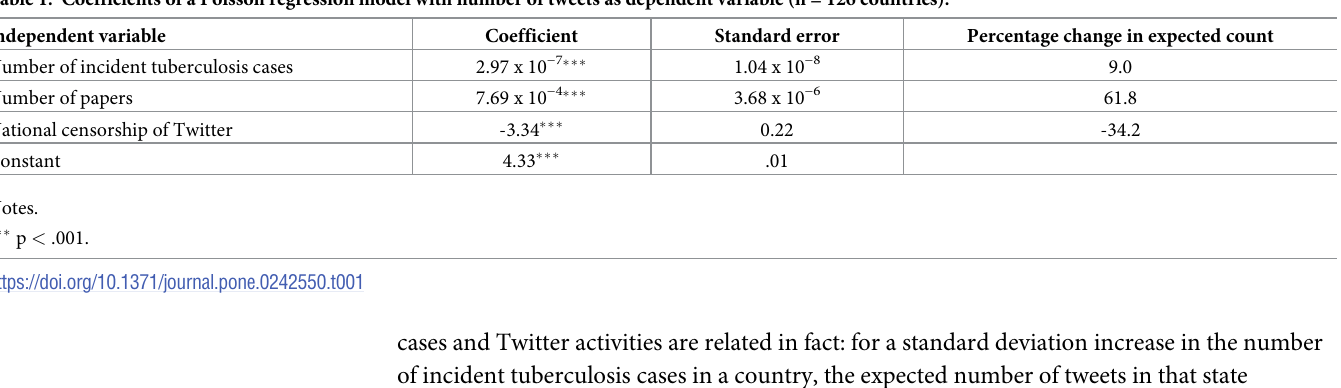
Table 1. Coefficients of a Poisson regression model with number of tweets as dependent variable (n = 126 countries).